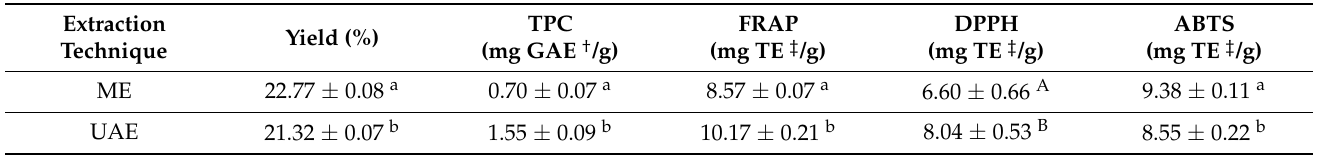
Table 1. Extraction yield (%), TPC and in vitro antioxidant activity (measured with the FRAP, DPPH, and ABTS assays) of sprout extracts obtained by ME and UAE. Results, reported as mean value ± standard deviation ( n = 3), are expressed on dry weight *.